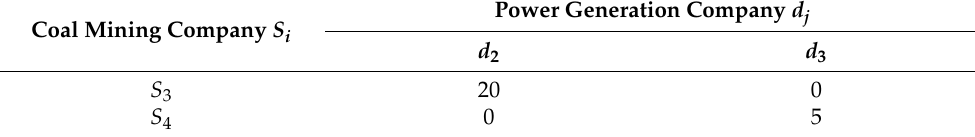
Table 3. Original allocation.